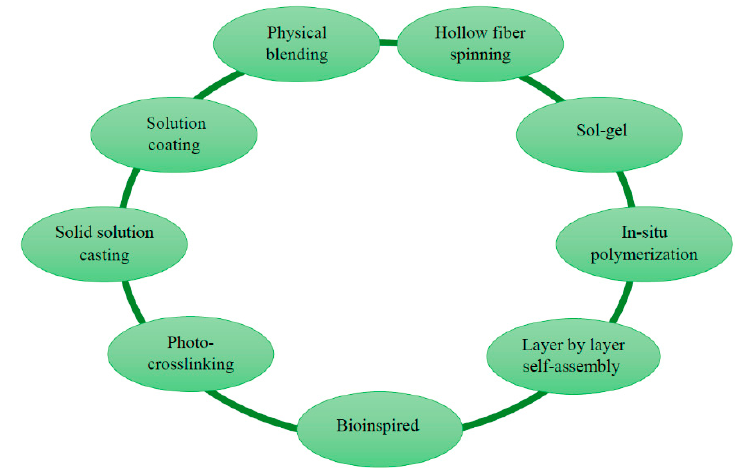
Figure 5. Commonly used fabrication